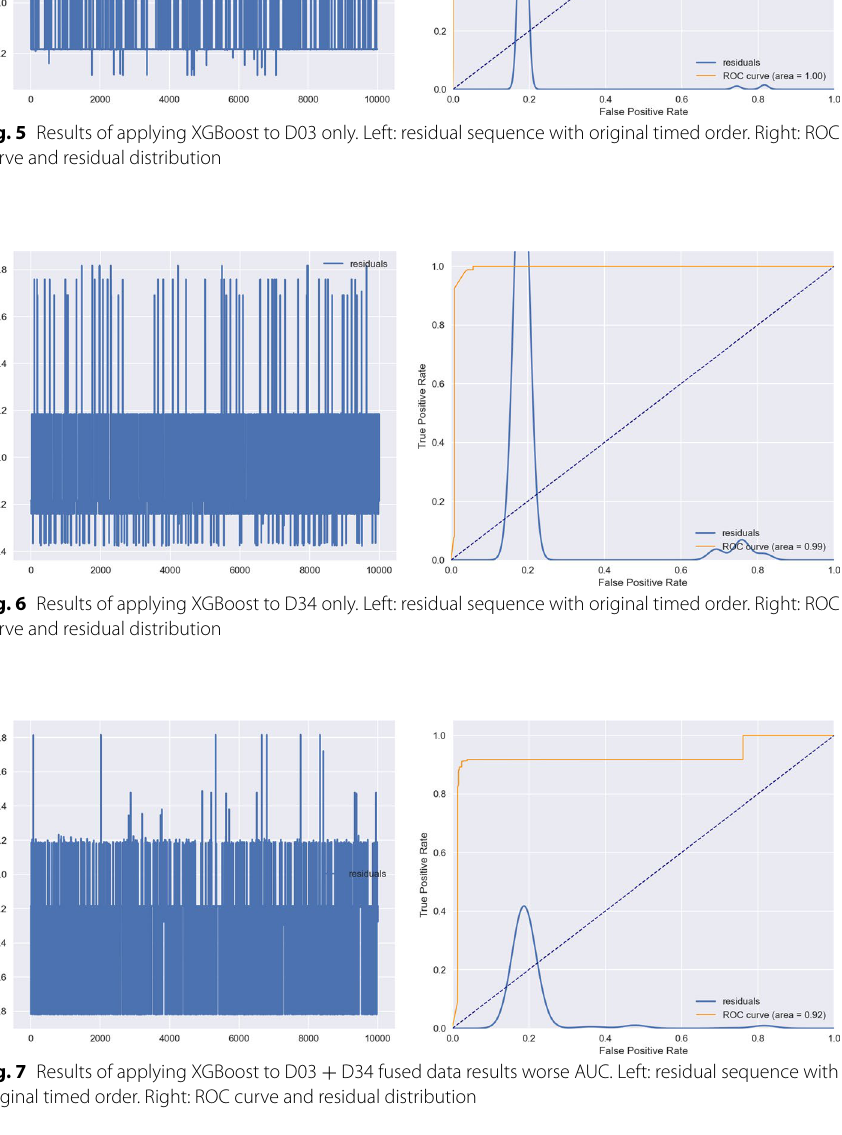
D34 fused data results worse AUC. Left: residual sequence with +